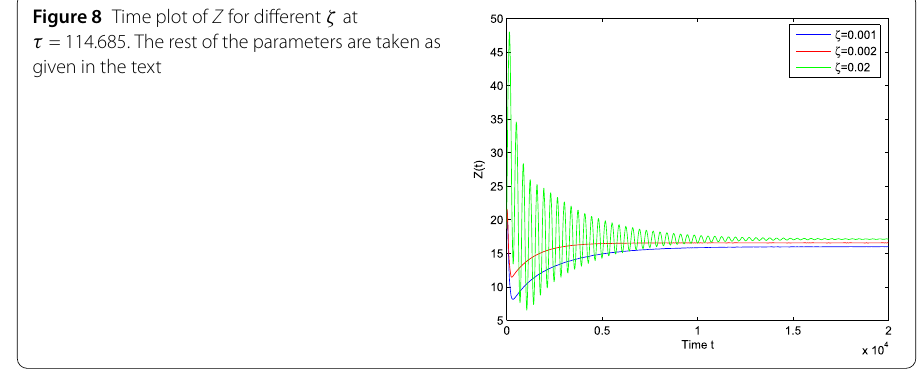
Figure 9 Dynamic behavior of system (21): projection on S – X – Z for different ζ at τ = 122.905. The rest of the parameters are taken as given in the